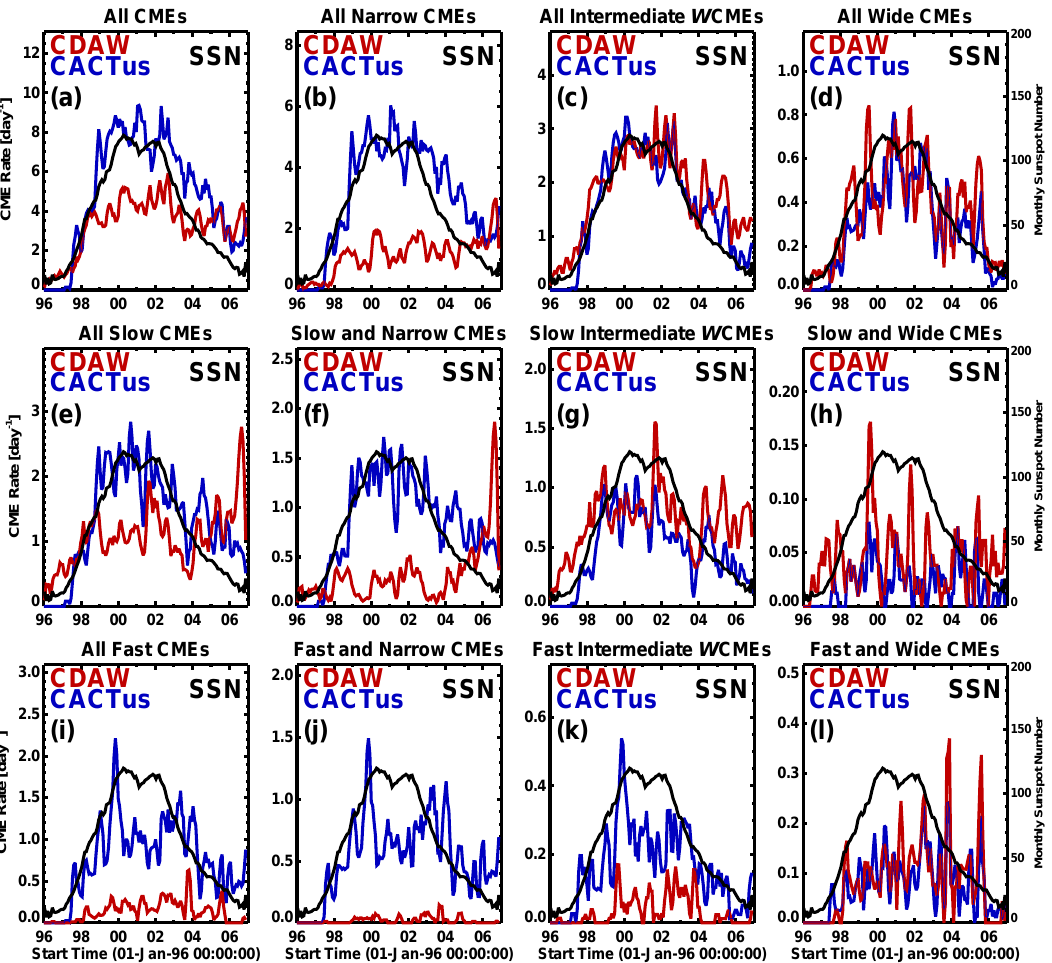
Fig. 6. Daily CME rate as a function of time. Red and blue lines are for the CDAW and CACTus catalogs, respectively (left scale). Black lines are smoothed monthly sunspot number (right scale) for the reference of the solar